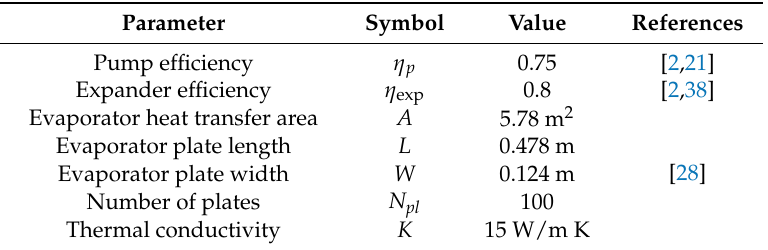
Table 6. The organic Rankine cycle (ORC) model